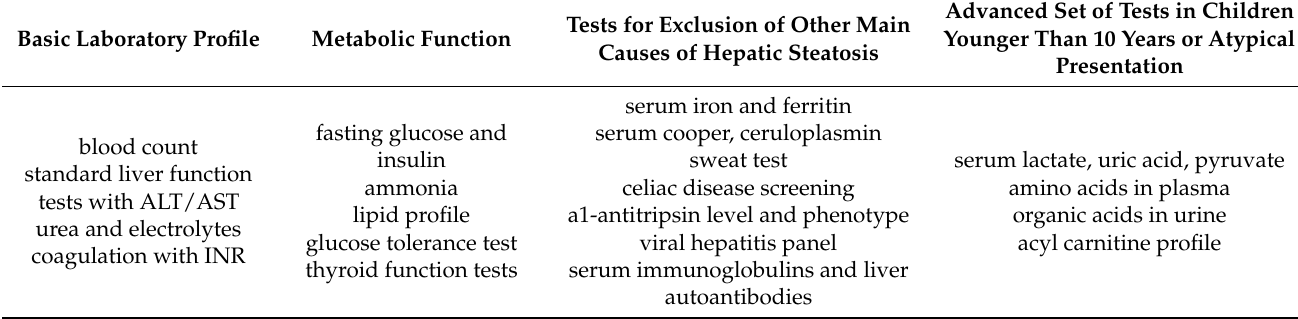
Table 1. Different sets of tests in children with suspected NAFLD according to the age and presentation.